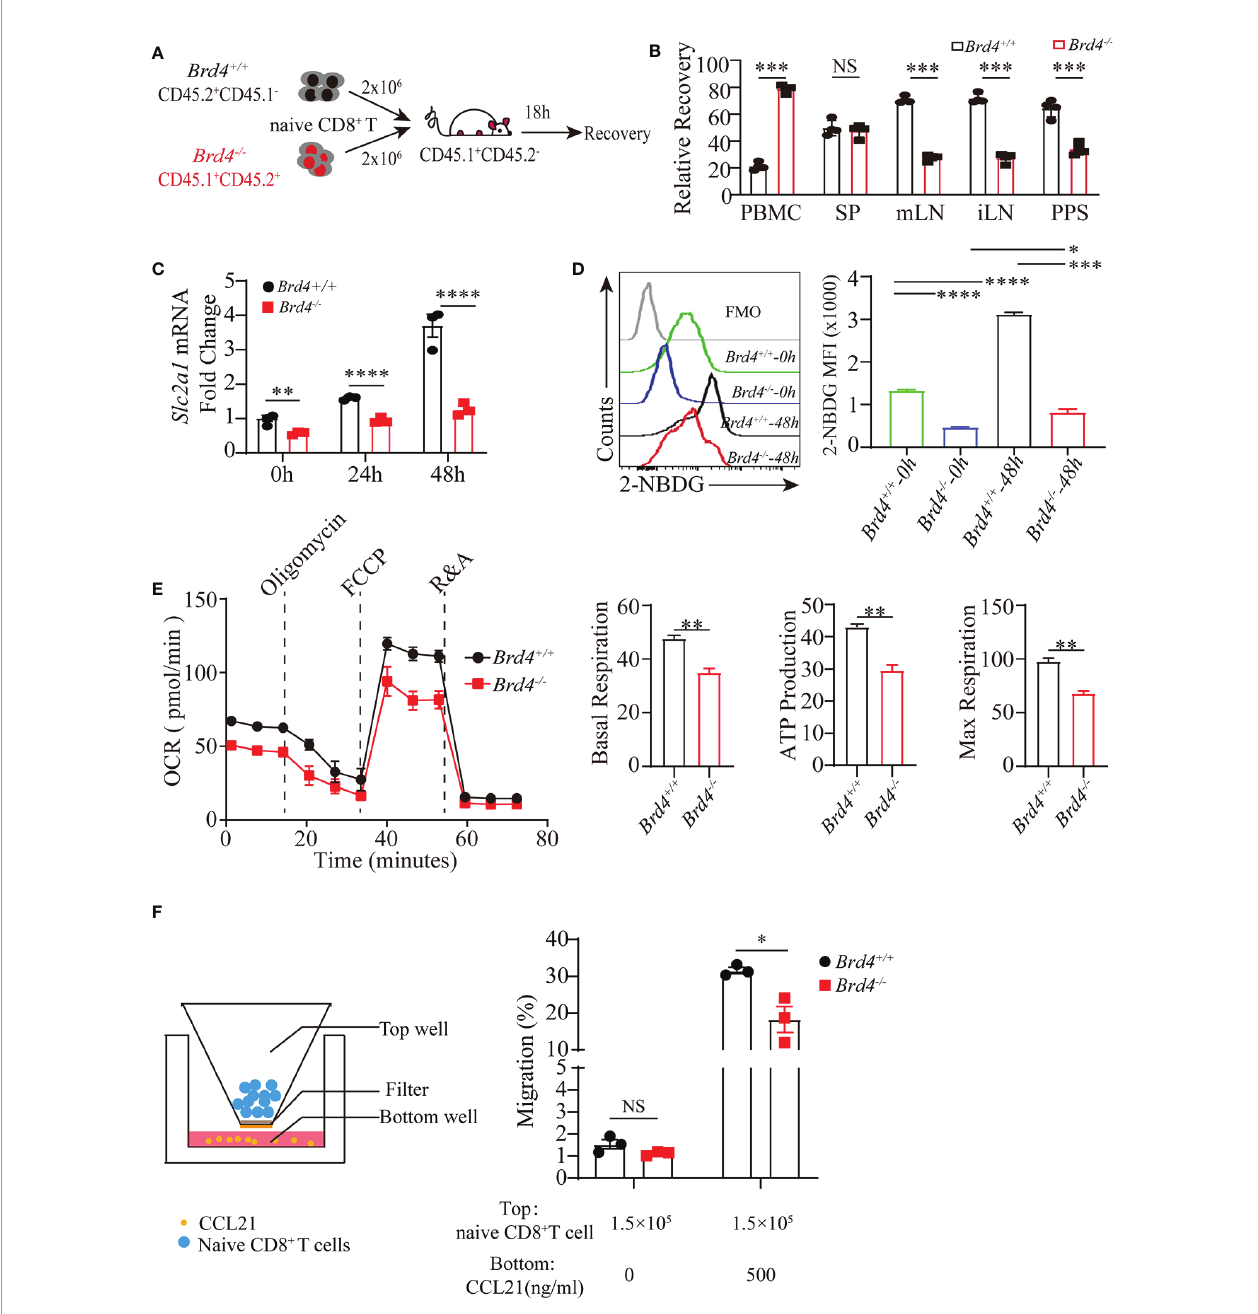
FIGURE 5 | Brd4 ensures CD8 + T cells homing and mitochondrial glucose oxidation. (A) Experiment setup. Puri fi ed Brd4 +/+ (CD45.1 - CD45.2 + ) and Brd4 -/- (CD45.1 + CD45.2 + ) naïve CD8 + T cells were mixed at a 1:1 ratio and then transferred into CD45.1 + CD45.2 - recipient mice. Donor cell recovery was checked in indicated tissues to assess their homing ability after 18h post-transfer. (B) Relative recovery of donor naïve CD8 + T cells in all checked organs. (C) RT-qPCR analysis of Slc2a1 transcription at distinct time point after CD8 + T cell receiving TCR stimulation. (D) Glucose uptake measurement in naïve and in vitro -activated CD8 + T cells from Brd4 +/+ and Brd4 -/- mice. (E) Oxidative phosphorylation in Brd4 +/+ and Brd4 -/- naïve CD8 + T cells was determined by measuring oxygen consuming rate after adding indicated compounds. (F) Schematic of in vitro migration assay in transwell plate (left) and the migration ef fi ciency of Brd4 +/+ and Brd4 -/- naïve CD8 + T cells in response to CCL21 chemotaxis (right). Two-tailed unpaired t -test was used to analyze two independent groups, while paired Student ’ s t -test was used when sample being compared from same mouse. To compare multiple groups, we used an analysis of variance (ANOVA). Results were indicated as mean ± sem (error bars). *p < 0.05; **p < 0.01; ***p < 0.001; ****p < 0.0001. NS, not signi fi cant. Each group includes at least 3 mice and each experiment repeats more than 2